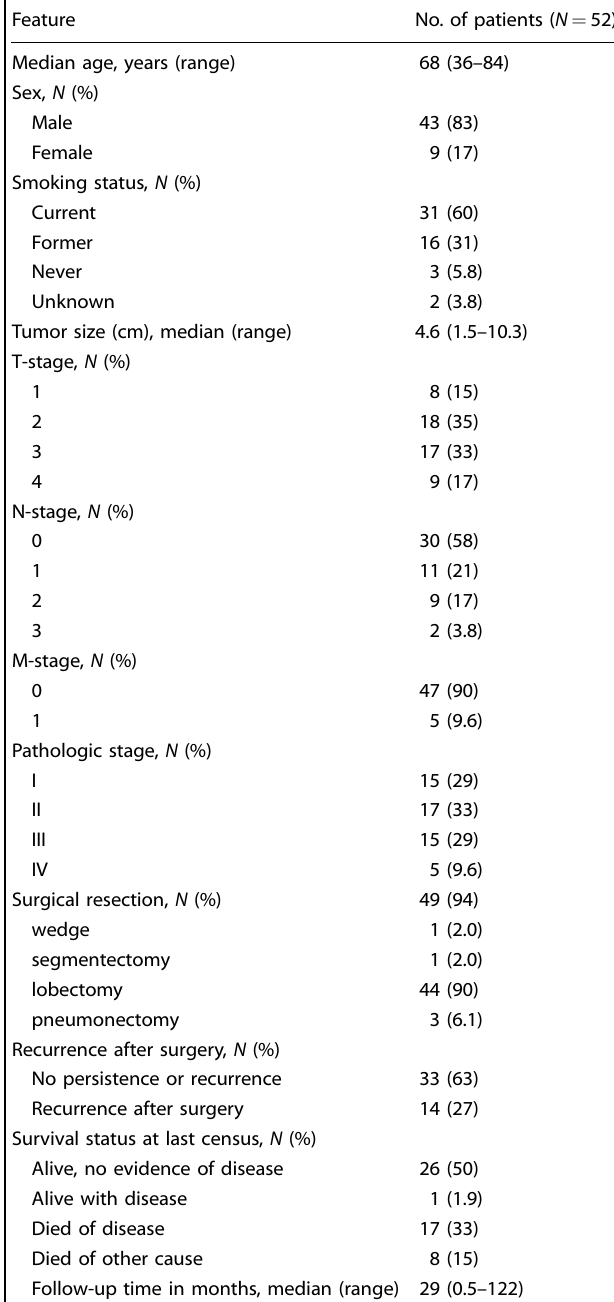
Table 1. Demographic features of the 52 patients with pulmonary pleomorphic